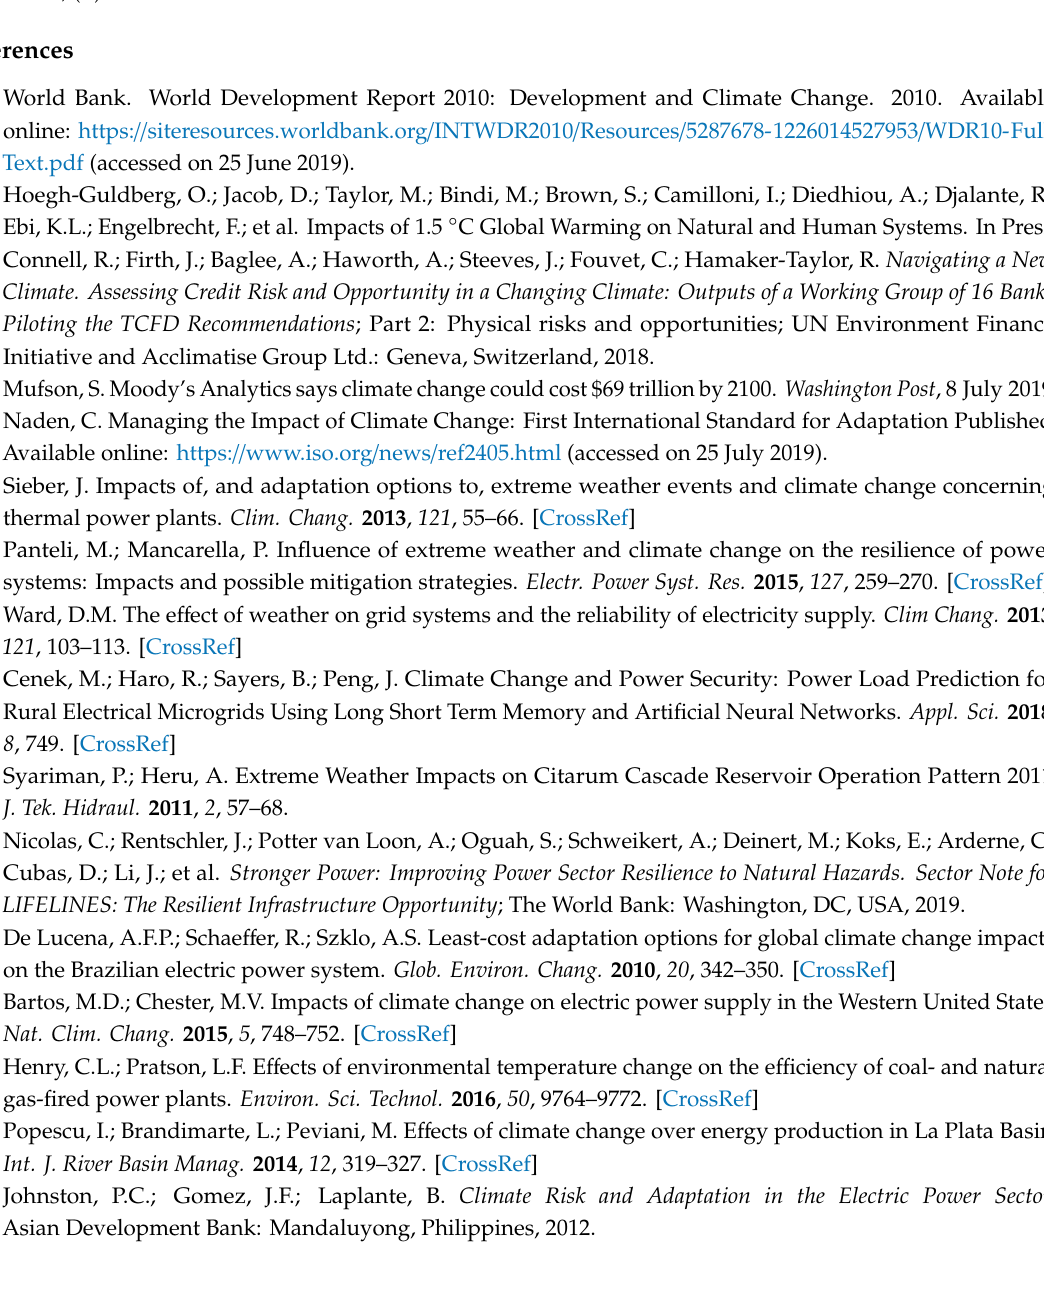
Figure A2. Historical data on electricity production and water inflow. Source: own fieldwork. ( a ) Saguling HEPP; ( b ) Cirata HEPP.